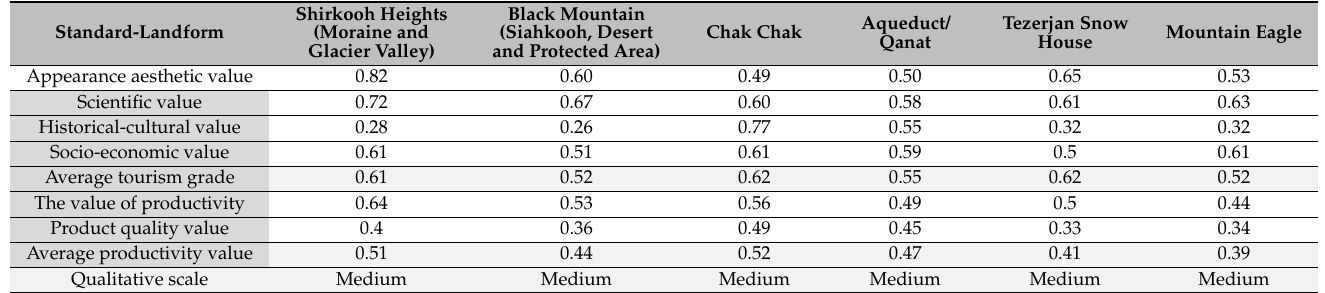
Table 2. The evaluation of tourism and interest values on existing iconic geomorphological landforms in the